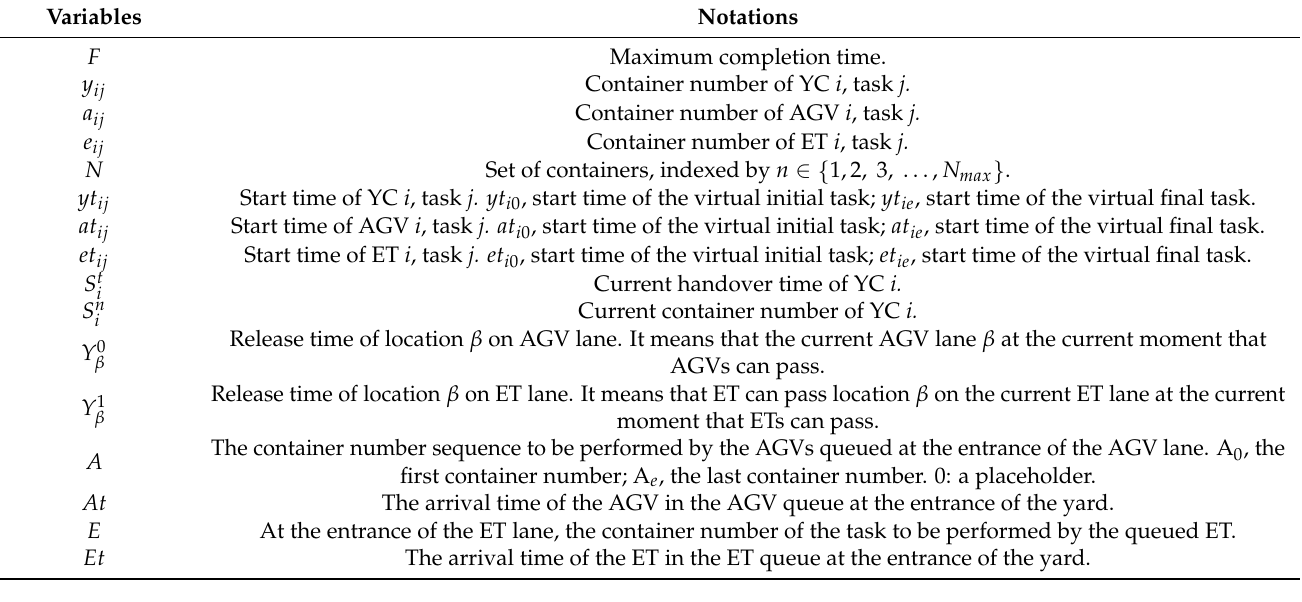
Table 2. Variable